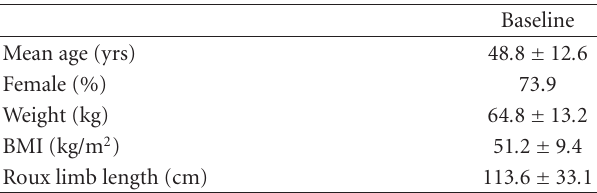
Table 1: Baseline demographic